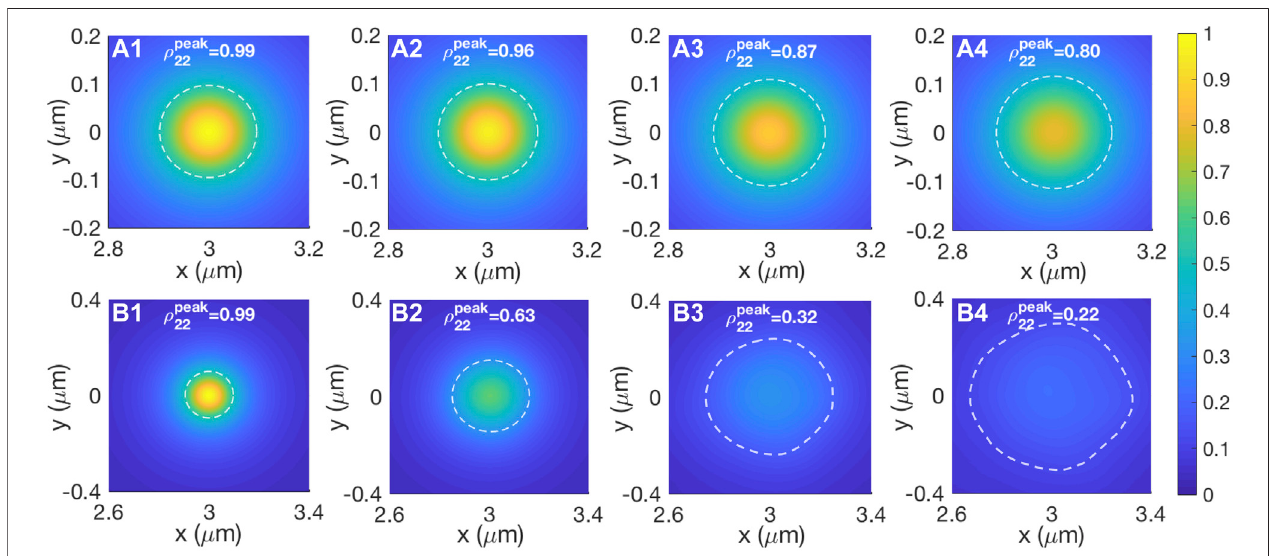
FIGURE 6 | (A1 – A4) 2D population distribution of ρ 22 ( r ) under different temperatures T = (0, 1, 5, 10) μ K . The peak value of ρ 22 ( r ) is given in the picture and the diameterofwhite-dashedringsstandsforthespatialresolution a r ,whichis a r =(200,206,222,247) nm,respectively.Here,weassumethemeasurementtimeis T meas = 1 μ s . Analogous to (A1 – A4) , (B1 – B4) show the case of T meas = 5 μ s and the calculated resolution is a r = (200, 308, 530, 687) nm. Every point is obtained by averaging over 500